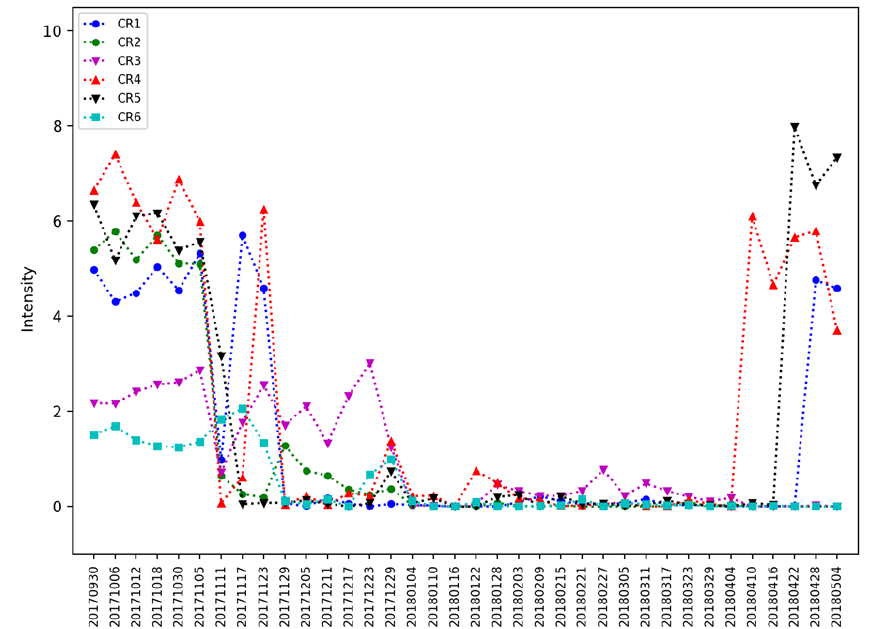
Figure 10. SAR image intensity time series in winter 2017–2018 over six CRs installed in the study